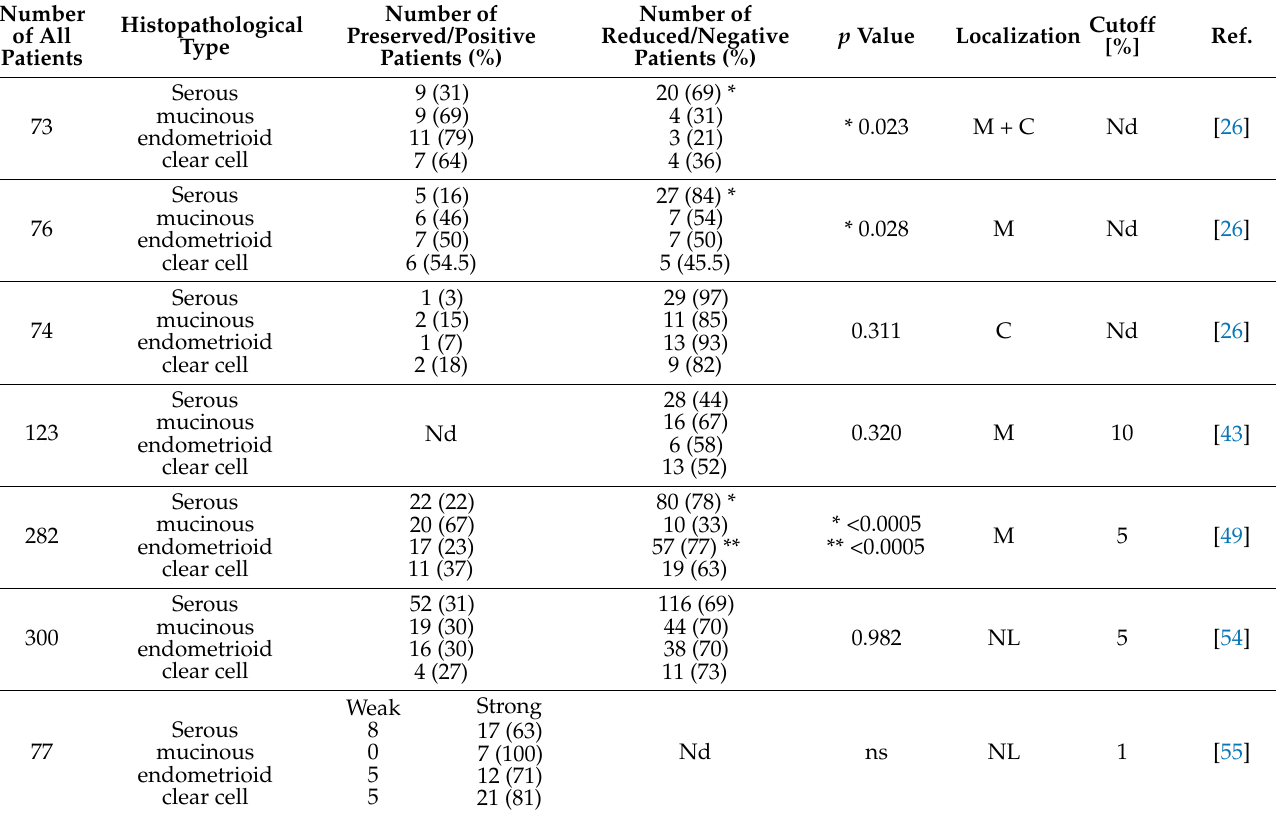
Table 6. The association of E-cadherin expression with histopathological type of EOC